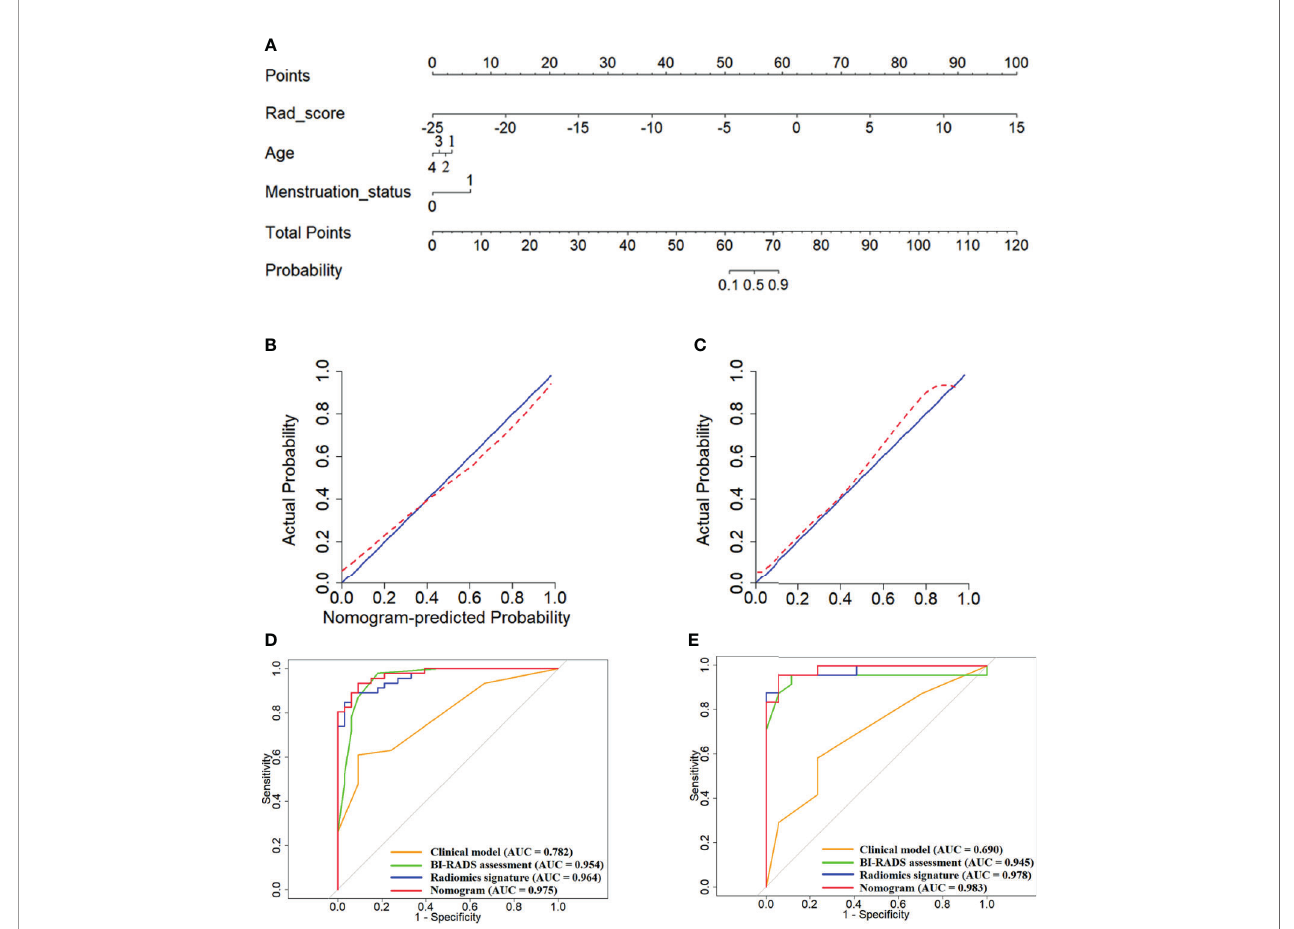
FIGURE 2 | Development and validation of the nomogram model integrating the combined Rad score, age and menstruation status. (A) Construction of the nomogram; (B, C) , Calibration curves of the nomogram in the training (B) and validation (C) cohort; (D, E) , ROC curves of the nomogram, combined Rad score and clinical model in the training (D) and validation (E)